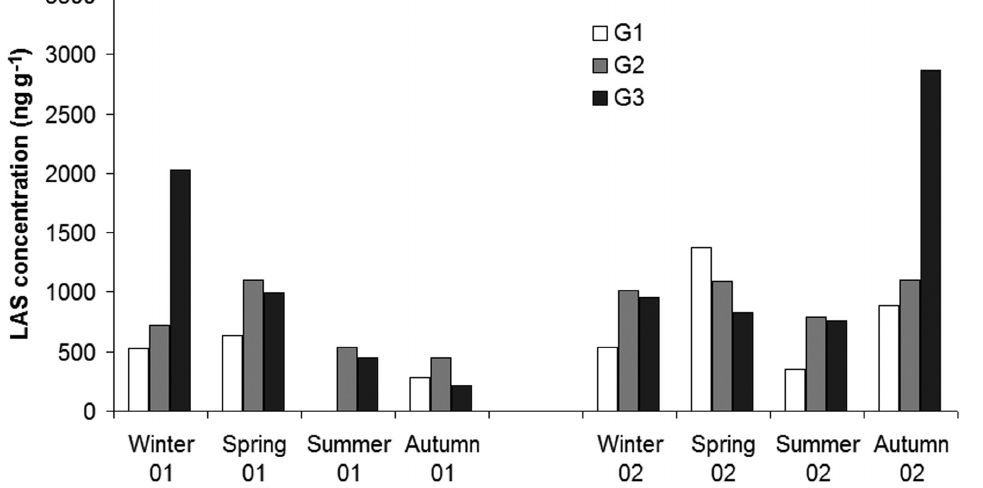
Fig . 3. – Annual variations in the LAS concentrations (expressed as ng g -1 ) during the years 2001 and 2002 in the Guadalete estuary (sampling stations G1, G2 and